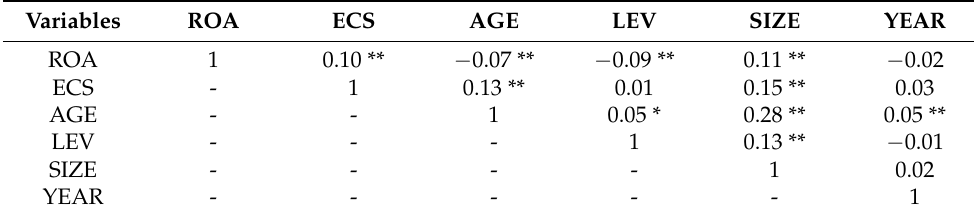
Table 6. Correlation analysis between variables (NEI).